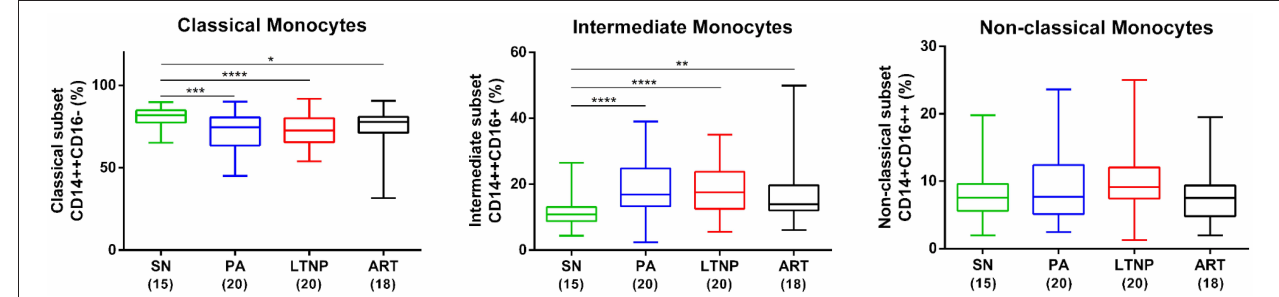
FIGURE 1 | Altered frequencies of monocyte subsets in HIV infection. Box and whisker plots showing comparison of frequency of monocyte subsets in PA ( n = 20), LTNP ( n = 20), and ART ( n = 18) groups with seronegative controls (SN, n = 15) (horizontal bar indicates median). Statistical significance was estimated by Kruskal-Wallis ANOVA followed by Dunn’s multiple comparison test; * P < 0.05; ** P < 0.01; *** P < 0.001; **** P < 0.0001. The expansion of non-classical subset (right-most panel) in ART-naïve groups was not significant by ANOVA but was observed to be significantly higher in LTNPs compared to both SN and ART groups by unpaired t -test ( P < 0.05 for